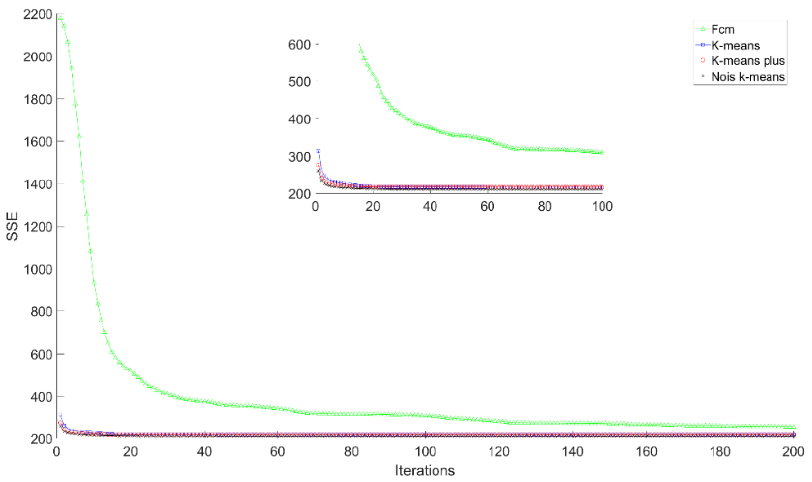
Figure 6. The SSE convergence curve for taxi GPS data (Rome (Italy)).